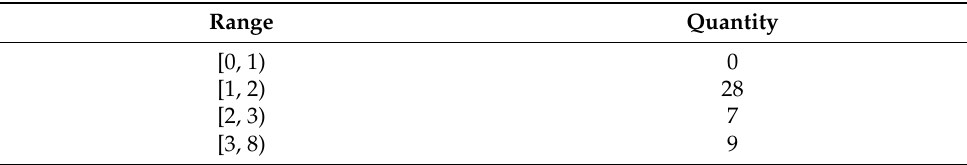
Table 3. The distribution of feature importance.